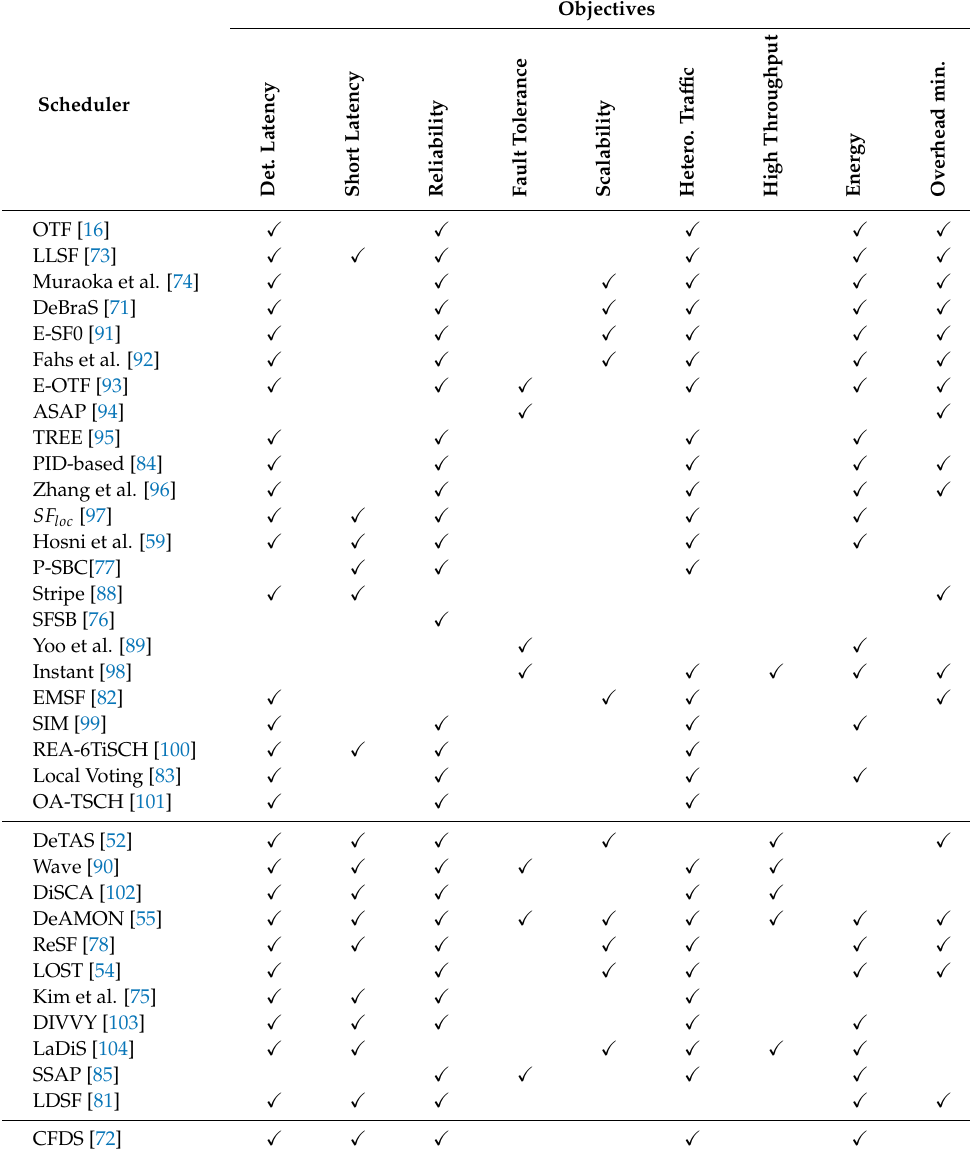
Table 4. Evaluation of collaborative TSCH